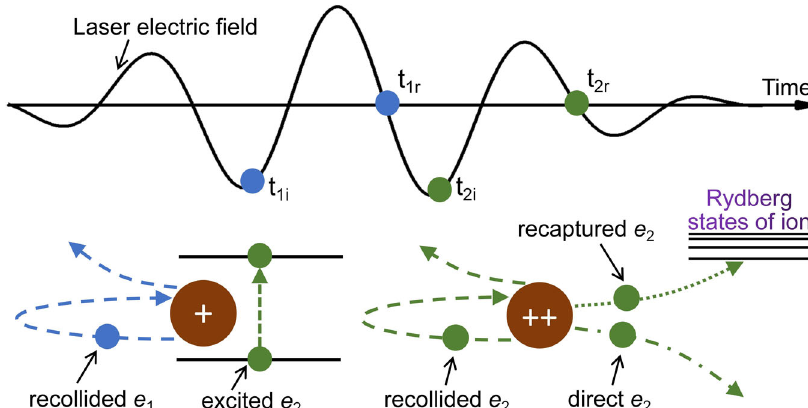
Fig. 1 Sketch map to illustrate the below-threshold nonsequential double ionization process. At time t 1 i , e 1 is fi rst ionized by the laser fi eld, then it is driven back to collide the parent univalent ion and excites e 2 at time t 1 r . e 2 is ionized from the excited state by the laser fi eld at a later time t 2 i . After that, e 2 may travel directly to the detector, or it may be driven back to recollide with the divalent ion similar to e 1 at time t 2 r , or it may also be recaptured into a Rydberg state of